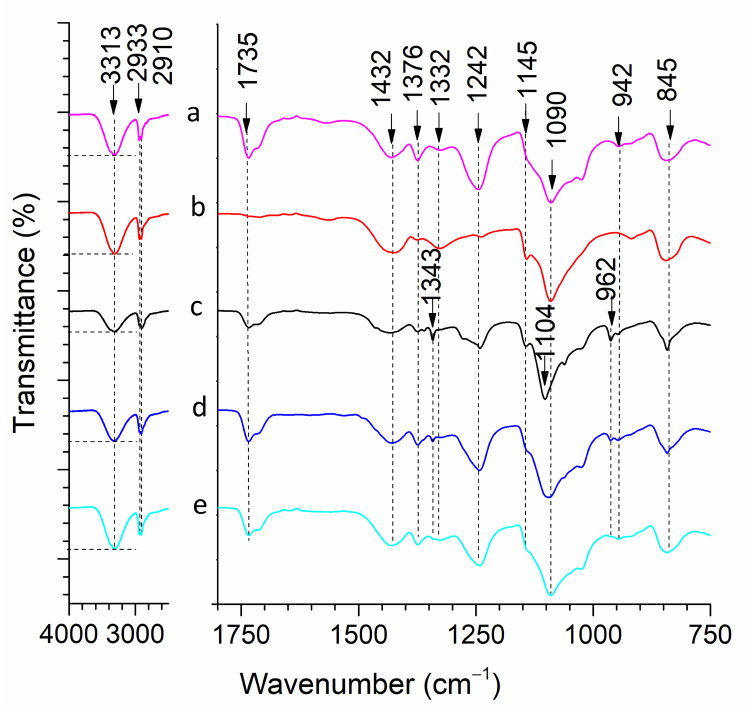
Figure 4. FTIR spectra of (a) PVA 10 wt.% fiber; (b) shell PVA-GO; (c) core PVA-PEG-SiO 2 ; (d) core–